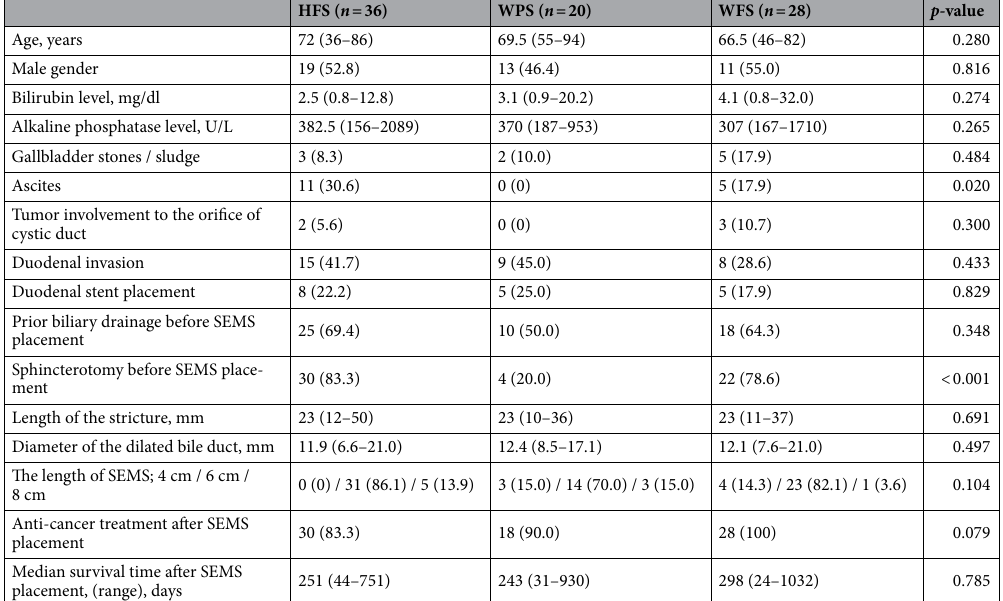
Table 1. Clinical characteristics of enrolled patients. Data are presented as median (range) or number (proportion). SEMS Self-expandable metal stent, HFS HILZO fully covered stent, WPS WALLFLEX biliary RX partially covered stent, WFS WALLFLEX biliary RX fully covered